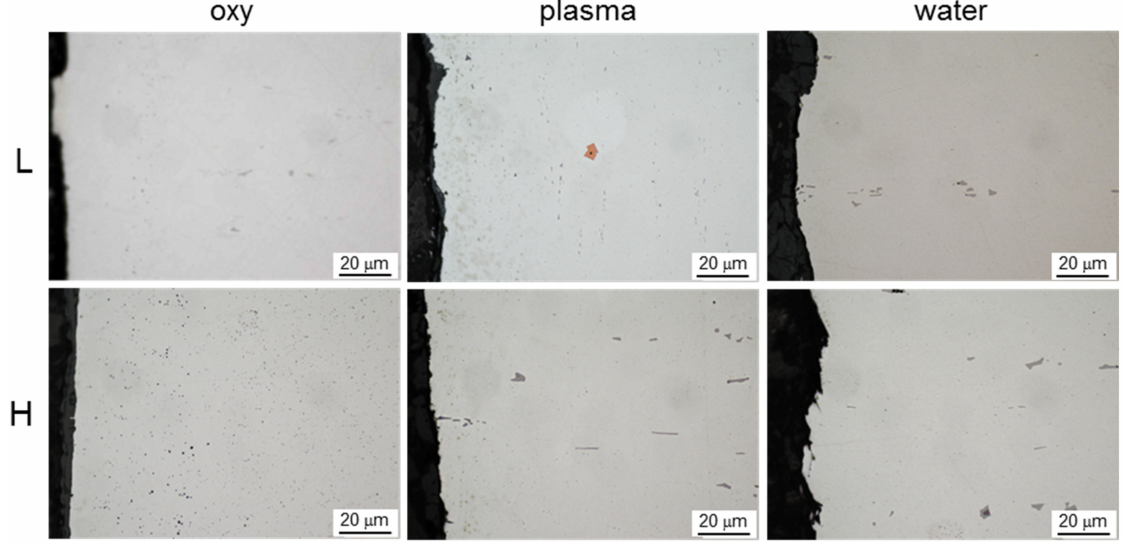
Figure 6. Optical images of Steel L and Steel H cut with the three studied methods (un-etched